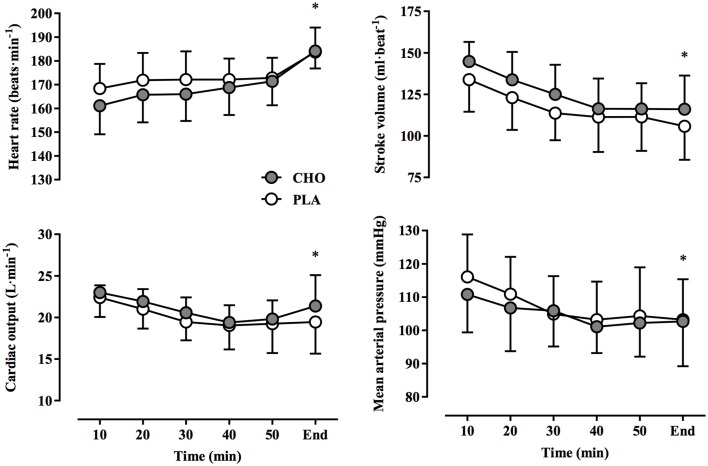
Heart rate, stroke volume, cardiac output, and mean arterial pressure at 10-min intervals and at the end of exercise during a 40-km cycling time trial in hot and humid conditions while rinsing the oral cavity with a carbohydrate solution (CHO) or taste- and color-matched placebo (PLA). No significant treatment-by-time interaction was observed; * indicates main effect of time (P < 0.01).